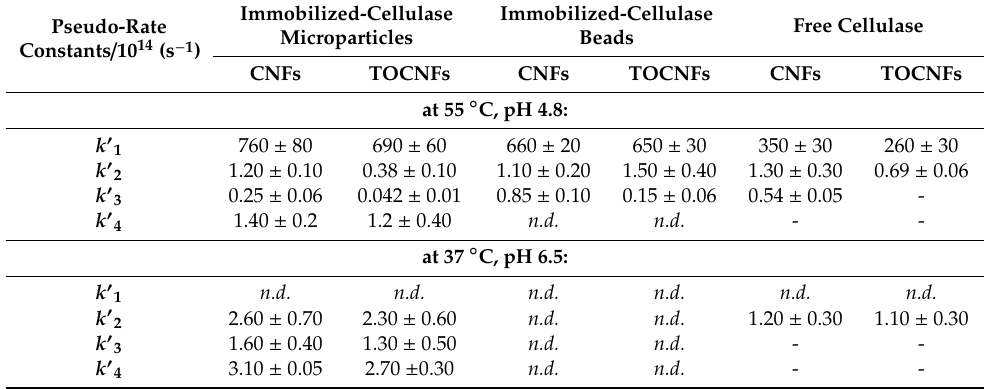
Table 2. Pseudo-rate constants k ′ 1 , k ′ 2 , k ′ 3 , and k ′ 4 of the kinetics of degradation of cellulose nanofibers CNFs and TOCNFs by the cellulase immobilized in alginate microparticles or beads and by the free enzyme.